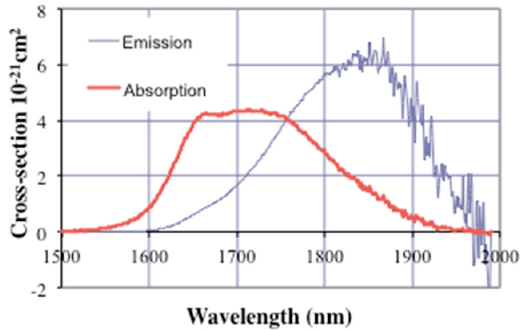
Figure 4. Absorption and emission cross section of the 1.0% Tm 2 O 3 -doped TeNbKTm samples deduced by using the McCumber analysis.